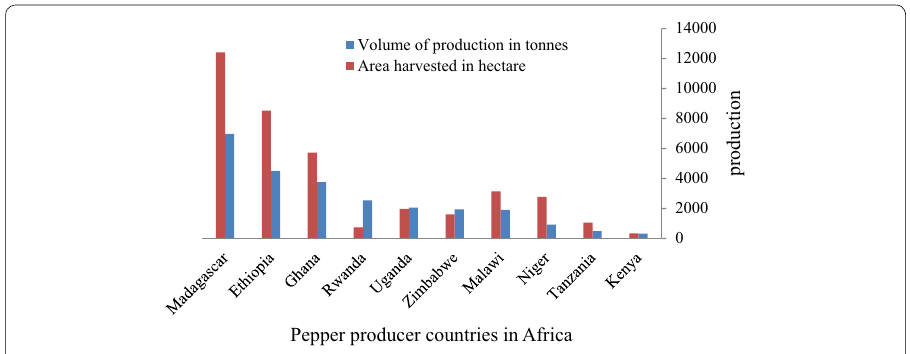
Fig. 1 Top 10 pepper producer countries in Africa Source : FAOSTAT